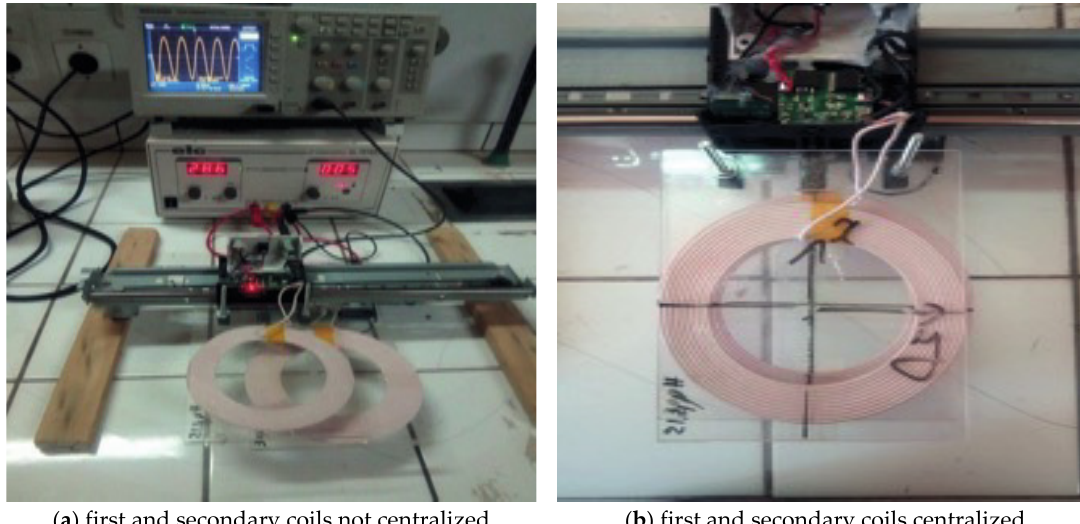
Figure 12. Real prototype for the wireless transfer system. Table 4. Real coils dimensions.